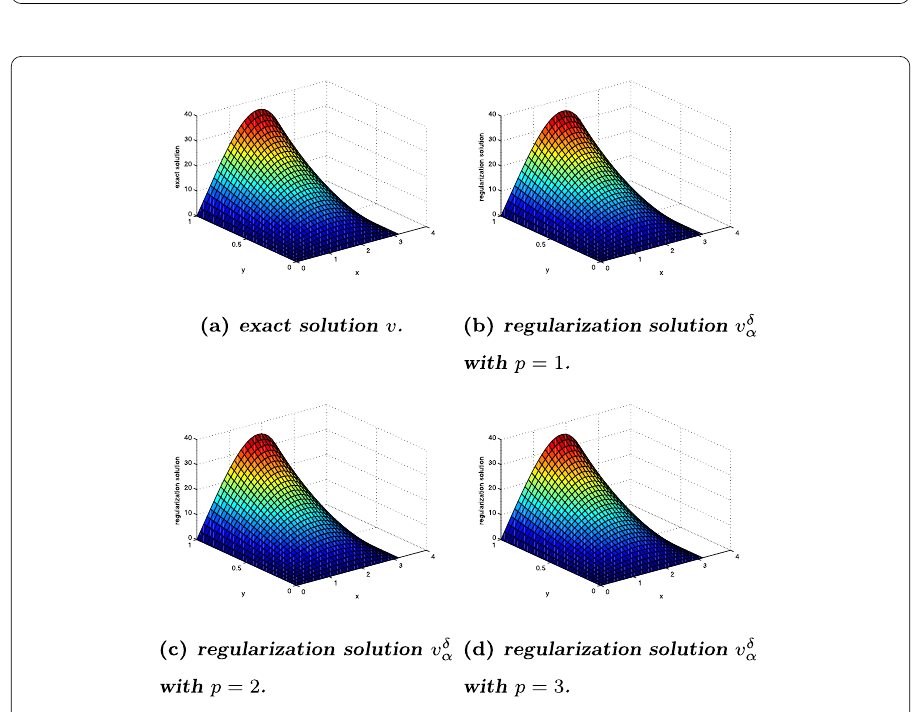
Figure 6 ε = 1 × 10 –2 , k =